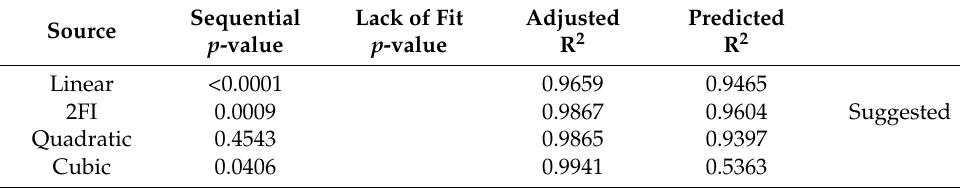
Table 6. Summary of 2FI model on the response ( Y 2 ) : water